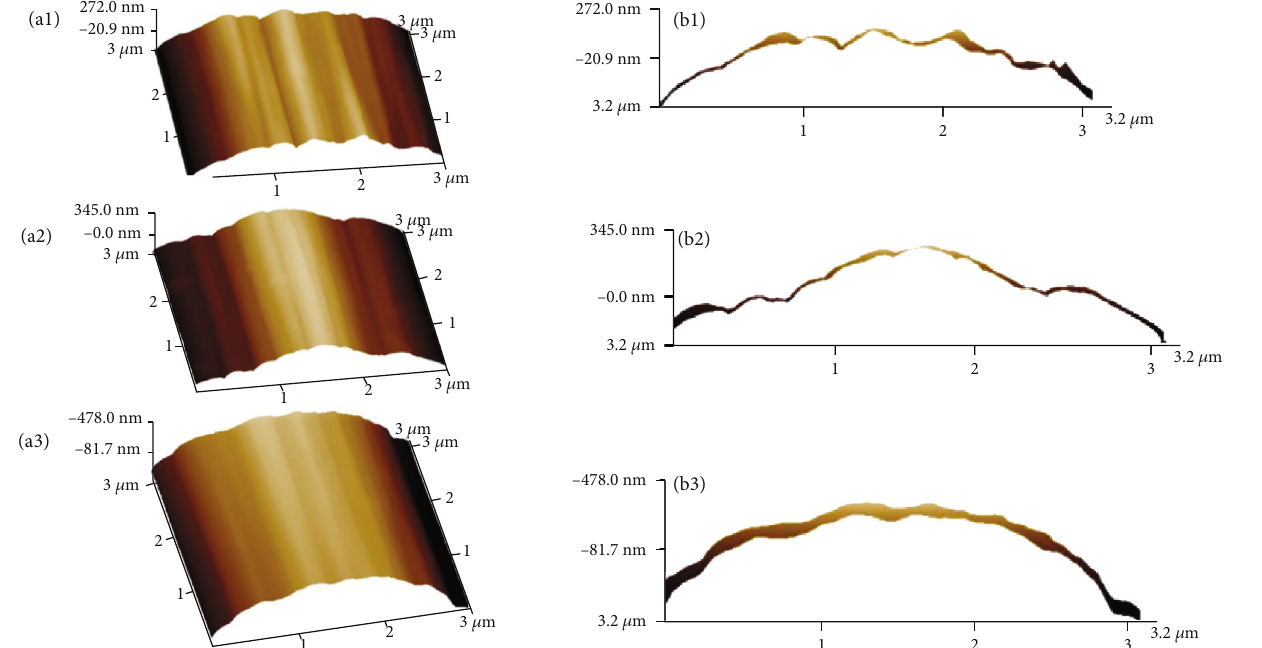
Figure 2: The surface AFM topography of carbon fi bers: (a) CCF800A; (b) CCF800B; (c) CCF800C.